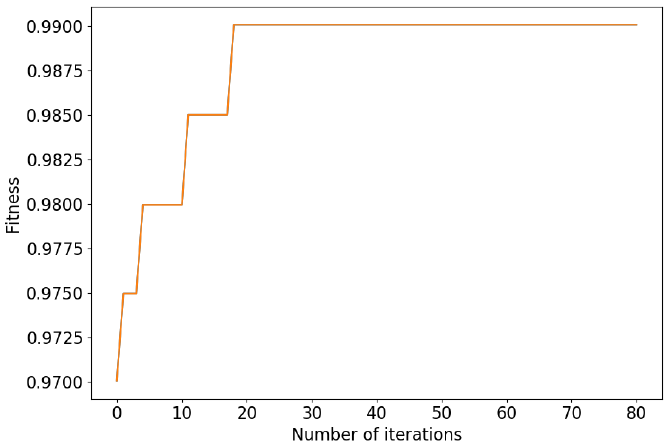
Figure 5. The fitness value of the PSO algorithm.